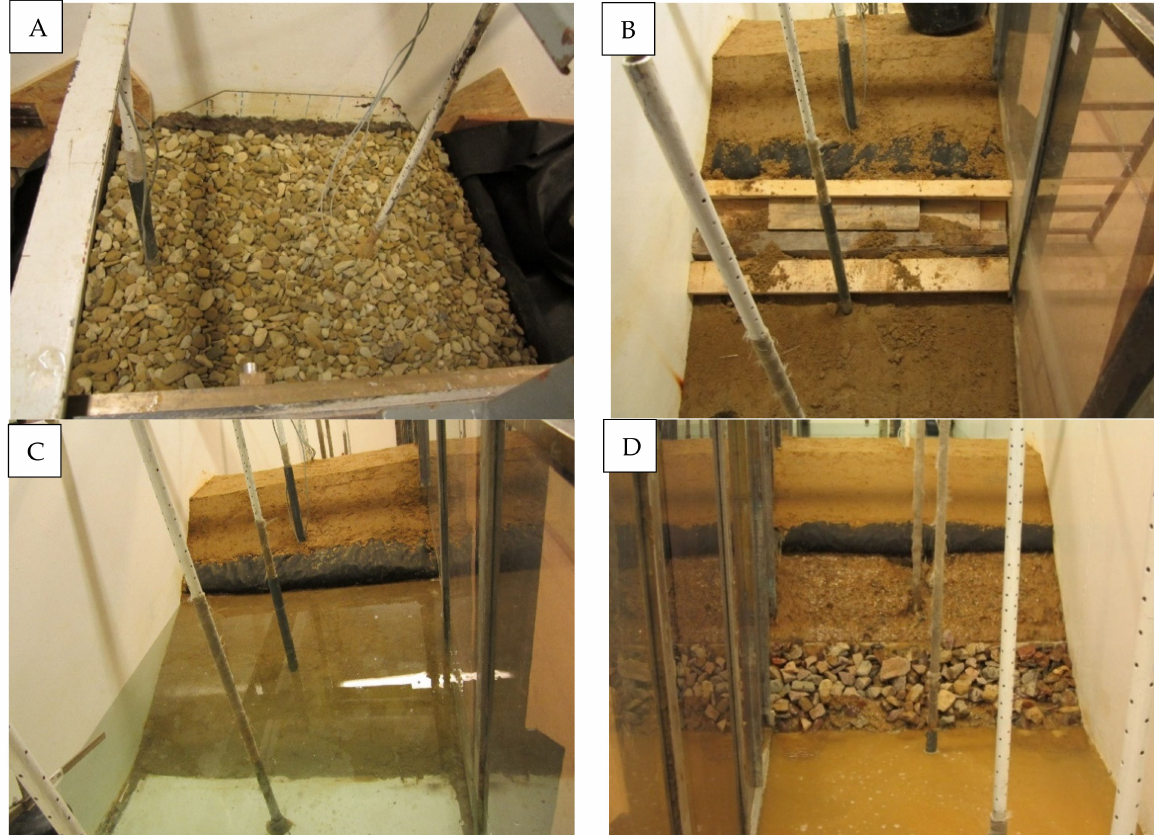
Figure 5. View of the model embankment slopes with embedded gravel drainage covered with a geotextile; ( A , B ) embank- ment composition: ( A ) gravel drainage forming; ( B ) profiling and securing slope banks; ( C , D ) after embankment execution: ( C ) waterside slope; ( D ) landside